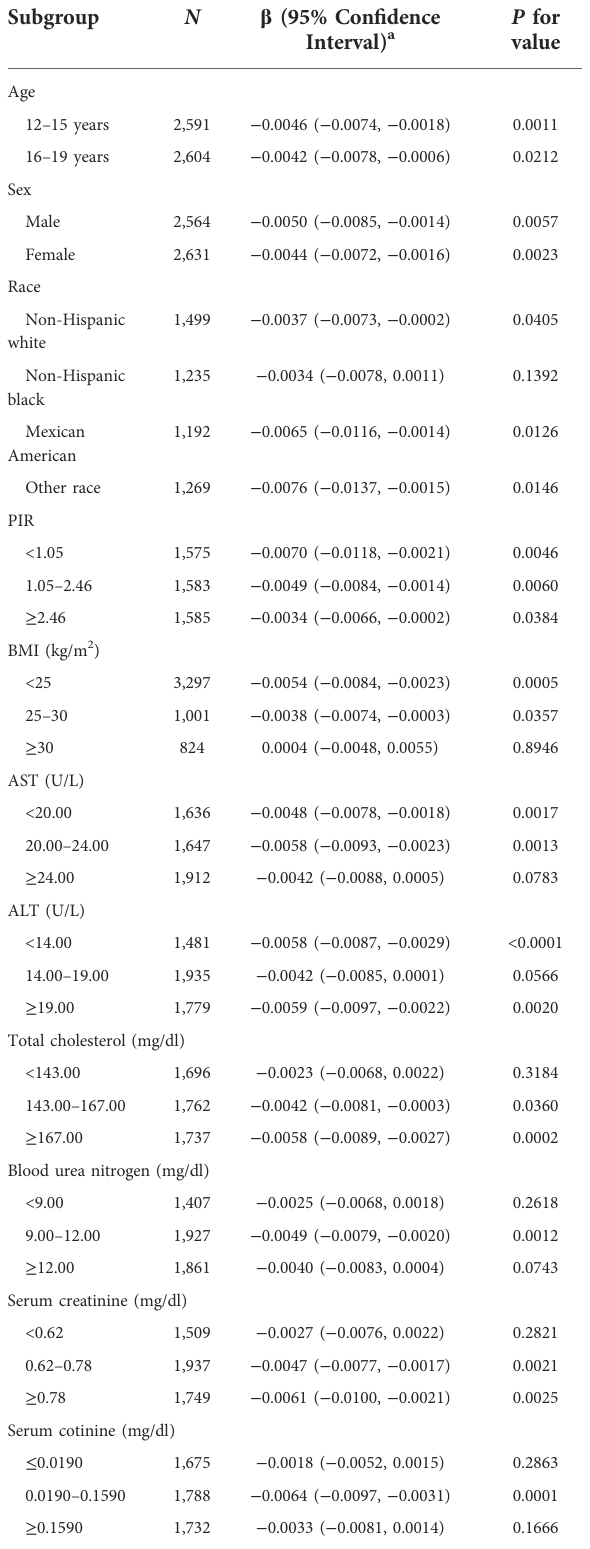
TABLE 3 Association between SFC and BLL for strati fi ed analyses according to baseline characteristics.